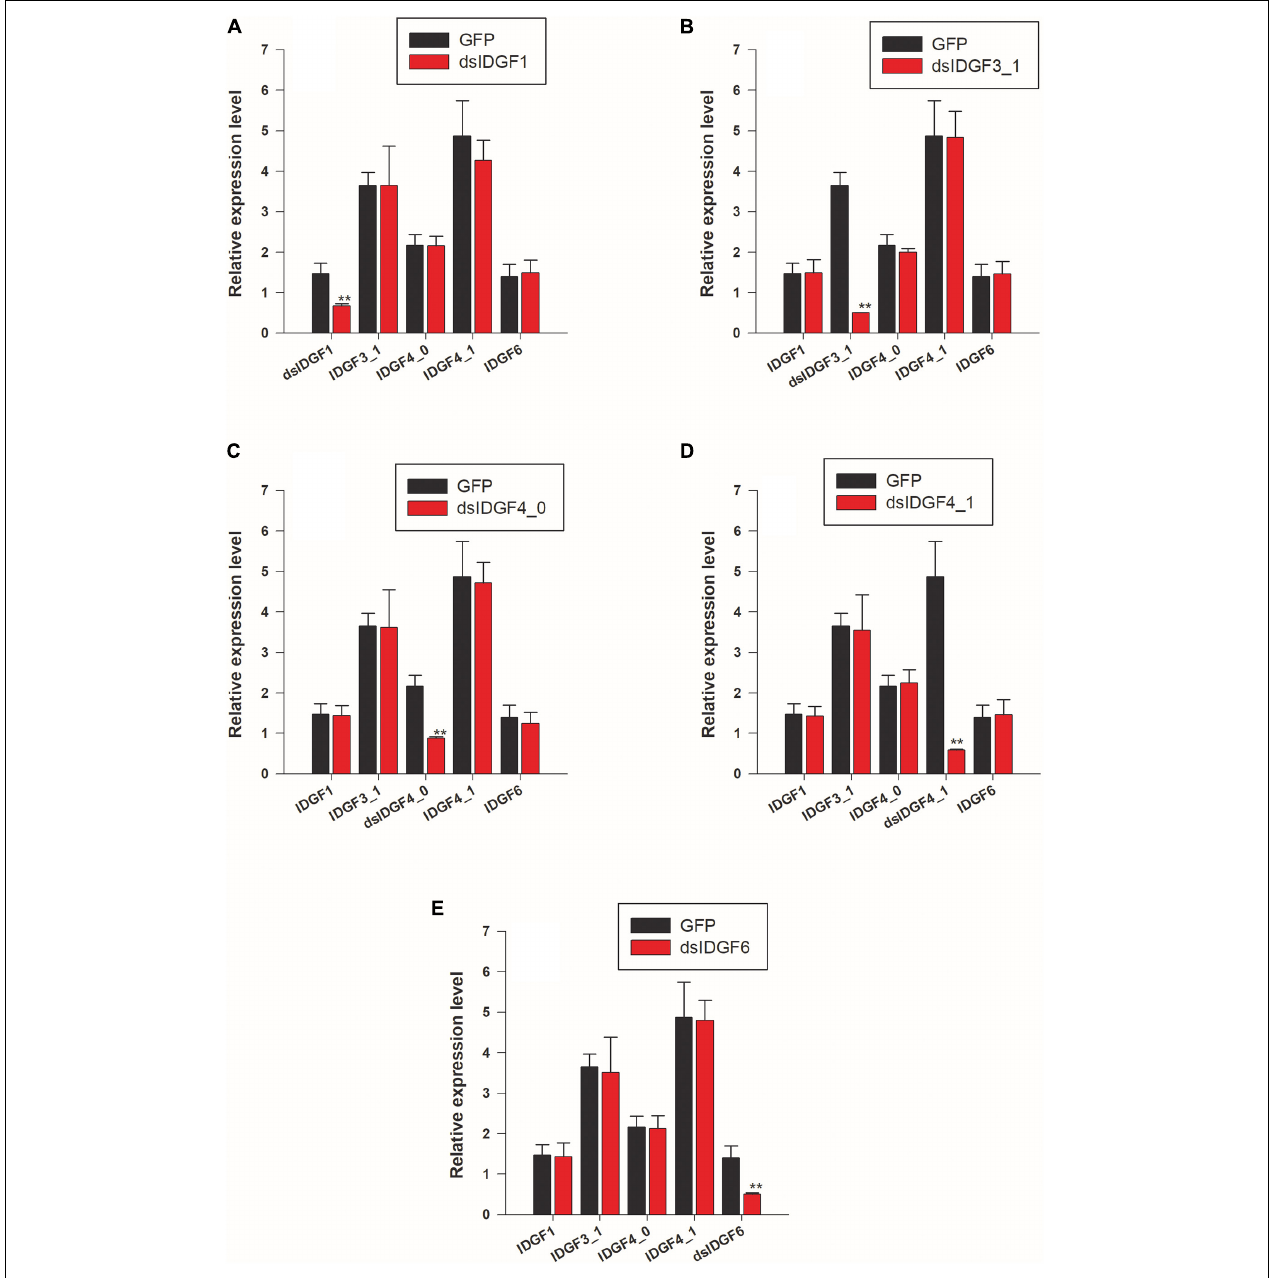
FIGURE 4 | RNAi suppresses only the target transcripts. (A) Larvae fed with ds IDGF1 and the other four genes are non-target transcript. (B) Larvae fed with ds IDGF3_1. (C) Larvae fed with ds IDGF4_0 . (D) Larvae fed with ds IDGF4_1 . (E) Larvae fed with ds IDGF6 . No effects observed on non-target transcript.